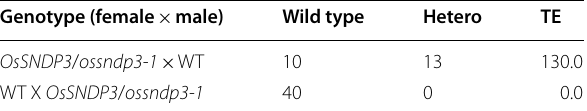
Table 1 Genetic transmission analysis of OsSNDP3 / ossndp3-1 by reciprocal crossing. The segregation ratio was analyzed using F1 progenies of represented crosses. The transmission efficiency (TE) represents the percentage of transmitted ossndp3 mutant alleles through male or female